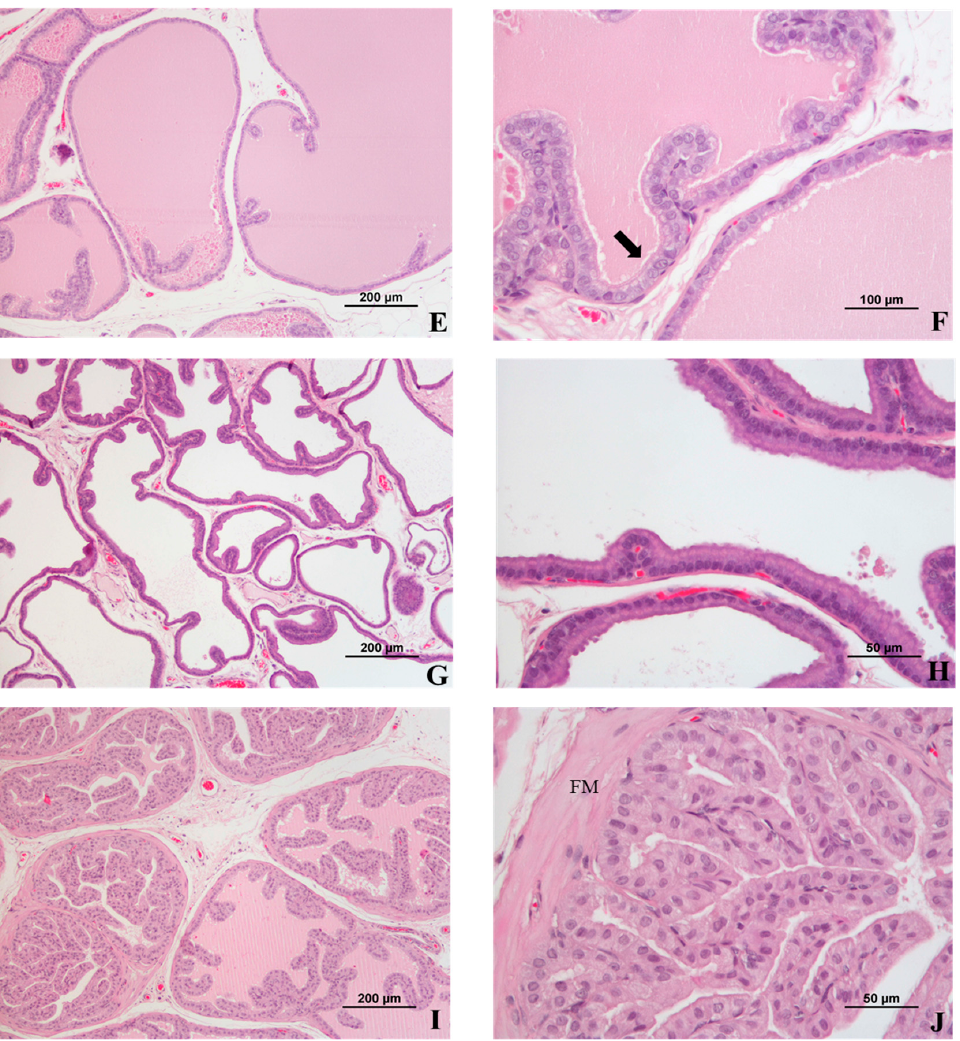
Figure 2. Microscopic features of normal rat prostate, 61 weeks of age. ( A ) Midtransverse section of the prostate showing prostatic urethra (PU) containing coagulated secretion (CS) (also denominated seminal plug or copulatory plug), and showing prostate ducts (PD) and ductus ejaculatorii (DE) enclosed by smooth muscle (SM) and surrounded by lateral prostate (LP). ( B ) Tissues surrounding PU with neighboring dorsal (DP) and lateral (LP) prostate lobes. ( C ) Dorsal prostate: small acini surrounded by a fibromuscular layer. ( D ) Dorsal prostate: cuboid to columnar cells presenting cytoplasmic blebs. ( E ) Lateral prostate showing moderate epithelial folding. ( F ) Lateral prostate acini lined by cuboid cell with supranuclear clear areas and brush border (arrow). ( G ) Ventral prostate showing acini with scarce infolding lined by basophilic cells. ( H ) Ventral prostate lined by columnar cells with basal nuclei and supranuclear cytoplasmic clear areas. ( I ) Coagulating gland showing tightly packed acini with intense infolding. ( J ) Coagulating gland presenting acini with high number of papillary structures, surrounded by a prominent fibromuscular layer (FM). ( A–J ) H&E